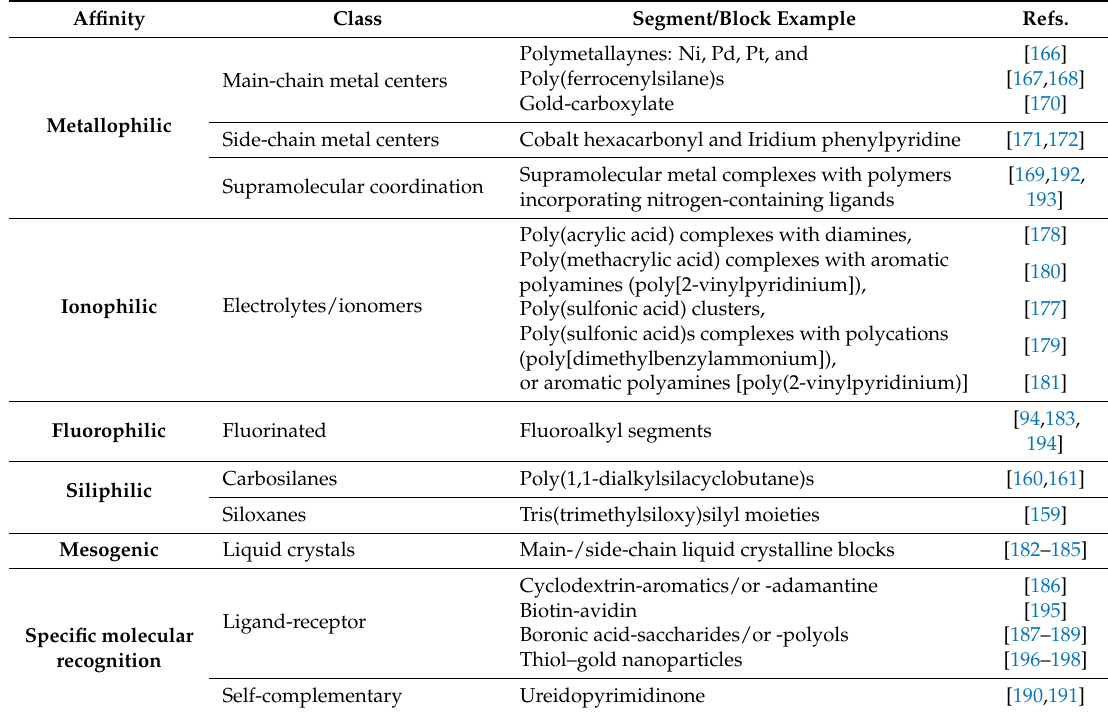
Table 1. Representative structure motifs present in polyphilic polymers (in addition to hydrophilic/ lipophilic